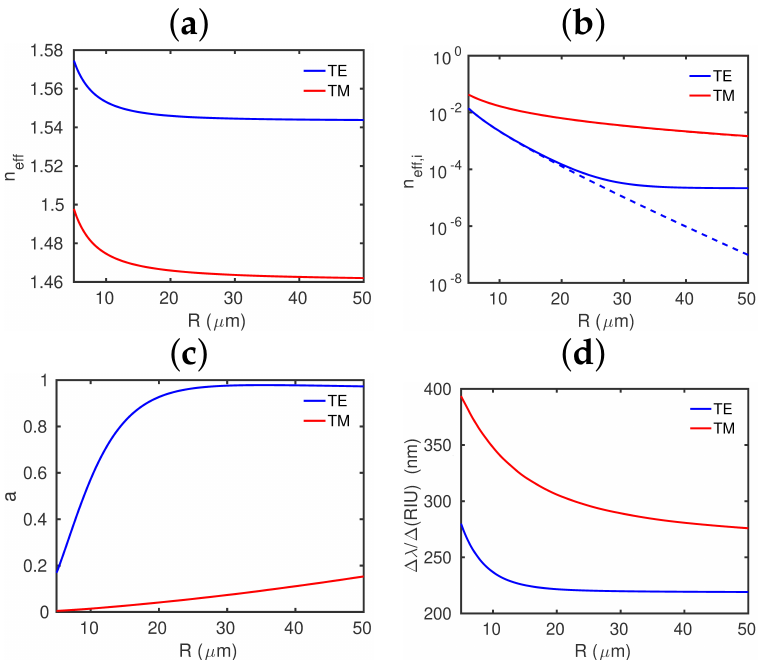
Figure 8. Results from the computations for a single-ring structure: variation of ( a ) the real part of the complex modal effective index, ( b ) the imaginary part of the complex modal effective index, ( c ) the round-trip field amplitude factor a and ( d ) the sensitivity ∆ λ / ∆ ( RIU ) , as a function of R and at λ = 1550 nm. Results for the TE- and TM-polarized mode are shown with blue and red solid lines, respectively. Dashed lines in panel ( b ) correspond to the results obtained when the effect of absorption in water is